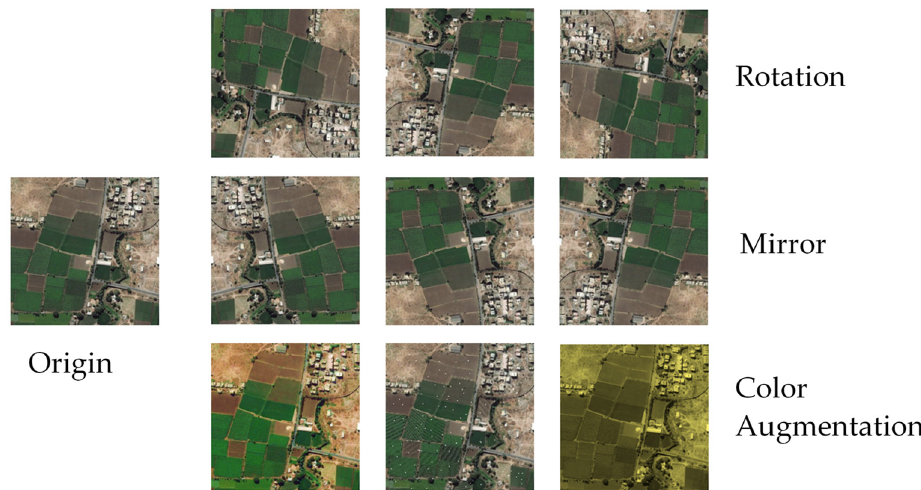
Figure 3. Data Augmentation. Three data augmentation methods are used. On the right side of the figure are 9 augmented images. In the first line, the three images are rotated 90 ◦ , 180 ◦ and 270 ◦ , respectively. In the second line, the three images are horizontally mirrored, vertically mirrored and centrally mirrored, respectively. In the third line, the three images are saturation enhanced, randomly noised and color adjusted, respectively.